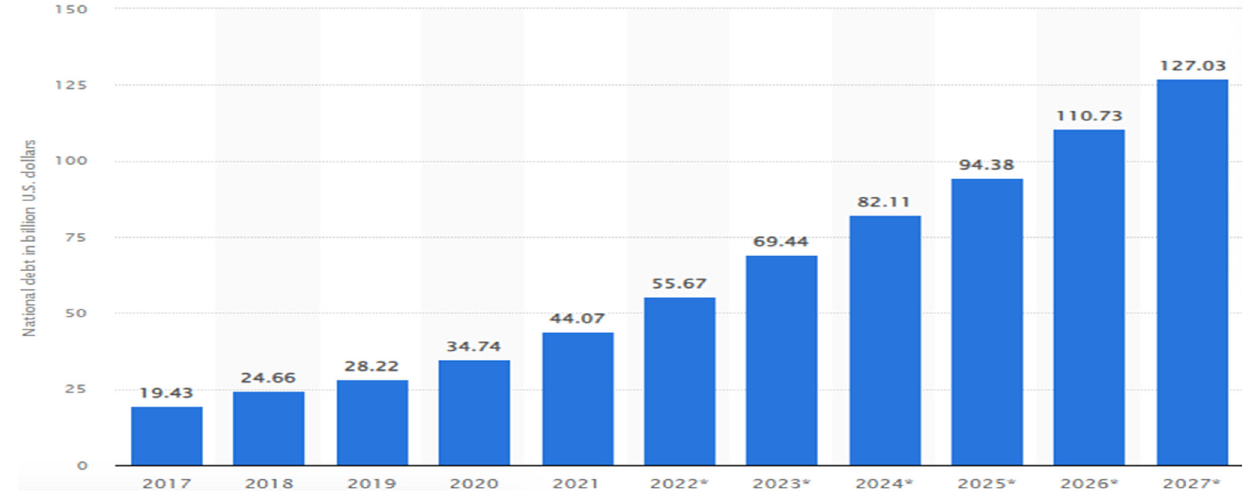
Fig. 3 Ethiopian national debt from 2017 to 2027 (in billion U.S. dollars). Source: Aaron O ’ Neill (2022) : National debt of